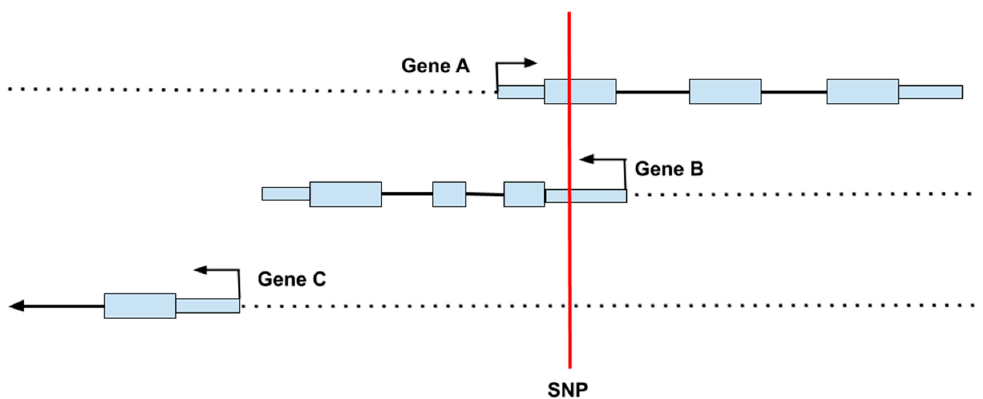
Figure 3. Since genes sometimes overlap, a single nucleotide polymorphism (SNP) can a ff ect more than one gene. In this example, the SNP (shown in red) is located in the coding region of Gene A, the 5 ′ untranslated region of Gene B, and the upstream regulatory region of Gene C. Table 2. Summary of examples of well-studied single nucleotide polymorphisms (SNPs) and their e ff ects on nutrition and